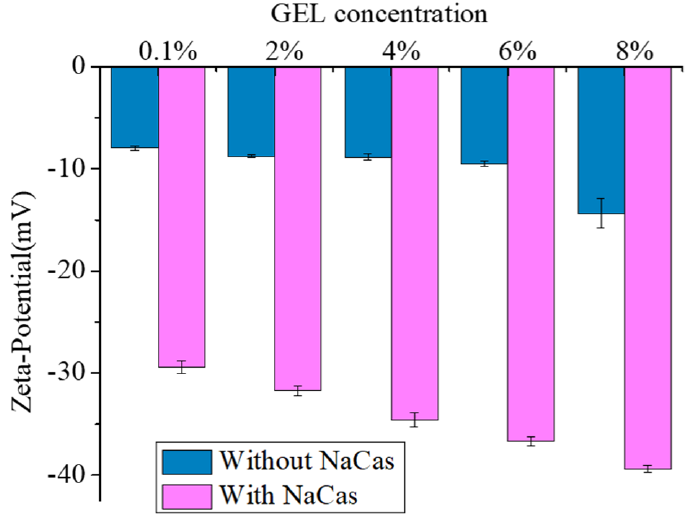
Figure 3. Zeta − potential analysis of CaCO 3 S/O/W emulsions prepared by different GEL concentra- tions (0.1, 2, 4, 6, 8 wt%).